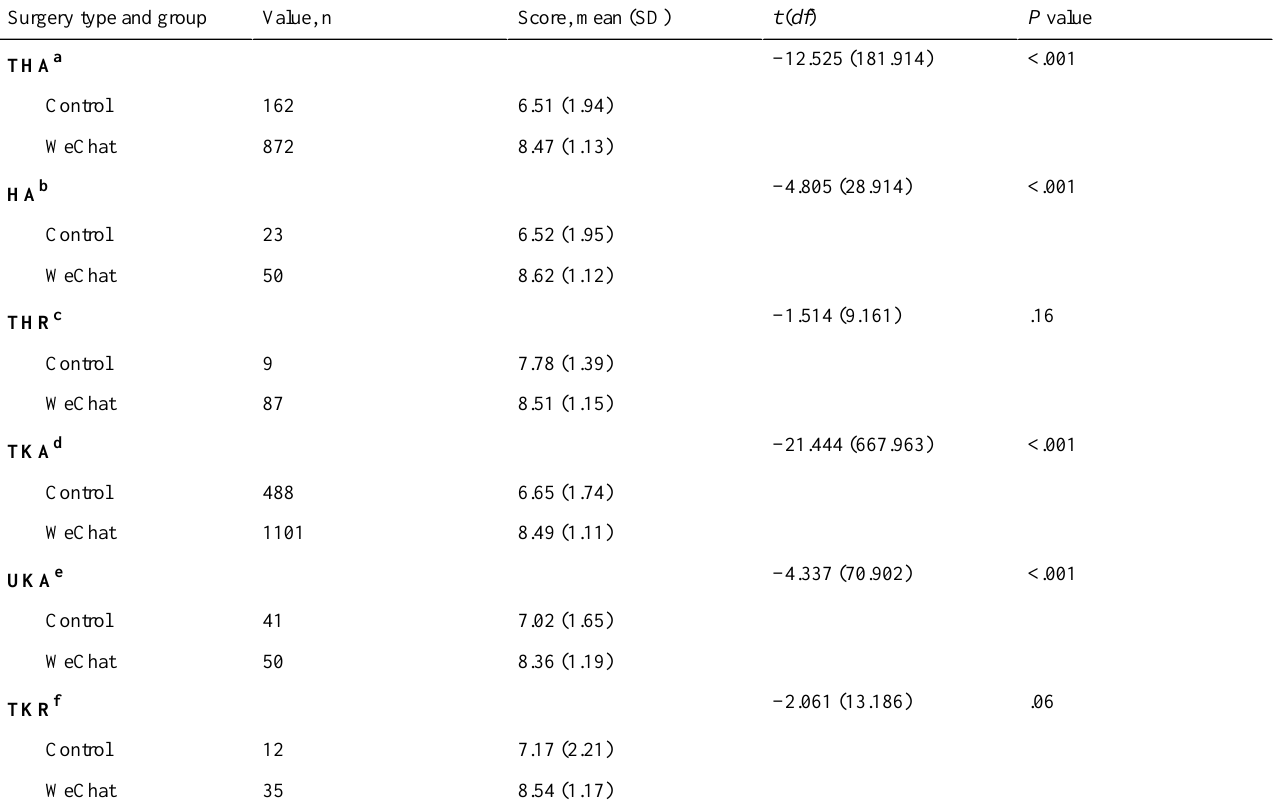
Table 2. Total satisfaction score in the control group and WeChat group by age and surgery type (N=2930).